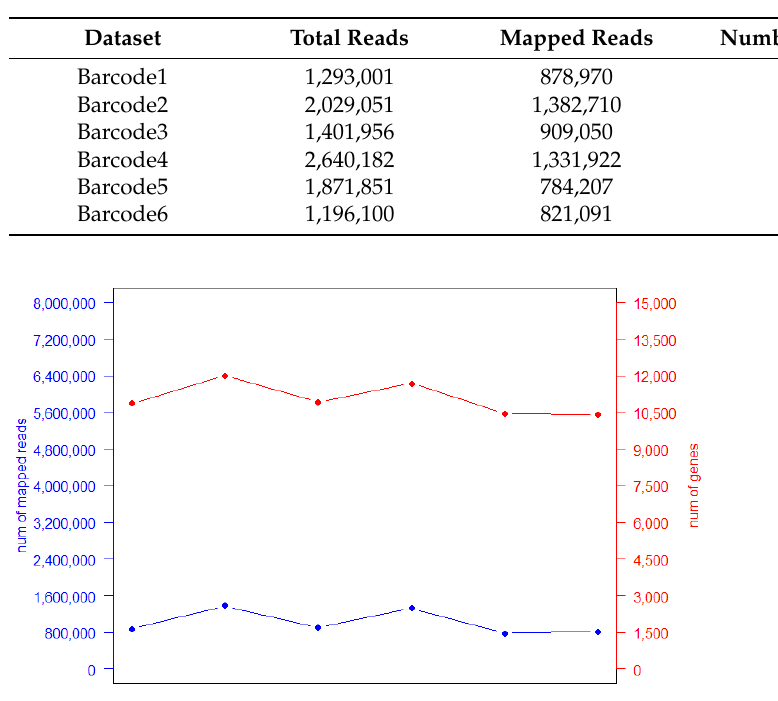
Figure 5. Sequencing results of each barcoded sample. Number of mapped reads ( red ) and identified genes ( blue ) obtained for each barcoded sample. Furthermore, the expression levels of the barcoded samples were compared to the values quantified in the DS5 subset (Figure 6). The high correlation (r p ≥ 0.9 and p < 10 − 5 ) between each barcoded sample and the DS5 subset revealed the reproducibility and high quality of the obtained results.